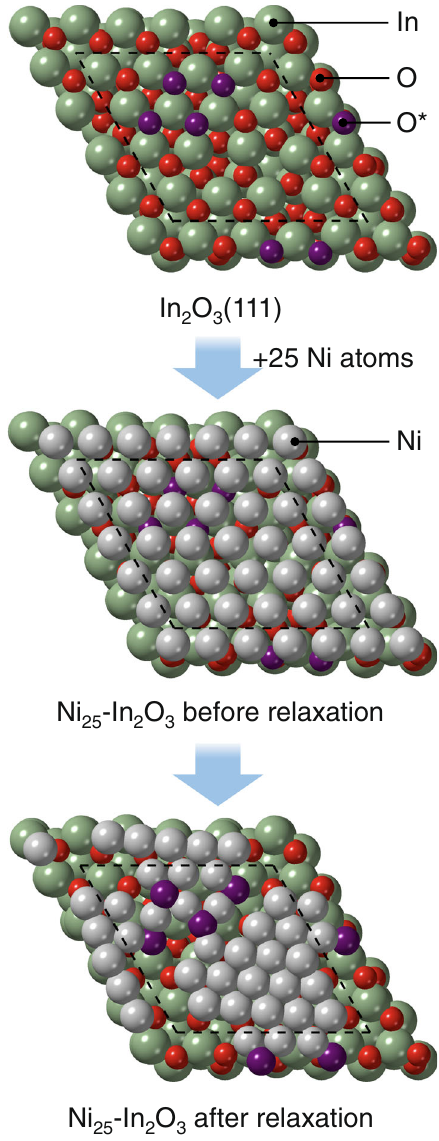
Fig. 4 Reconstruction of an In 2 O 3 (111) unit cell bearing a metallic nickel layer. The sketches show the restructuring of the interface between a nickel layer and the underlying In 2 O 3 . The pristine oxide surface is covered with a commensurate nickel layer, in this case containing 25 atoms. This structure is relaxed following a standard energy minimization algorithm. Given the corrugation of the In 2 O 3 surface and the Ni-O and Ni – Ni relative binding energies, some oxygen atoms are stripped from the oxide (colored purple) and isolated hexagonally arranged Ni-patches are formed upon the relaxation. The dashed lines in the models indicate the border of the unit cell of In 2 O 3 along with the (111) termination. The relaxation process is shown in Supplementary Movie